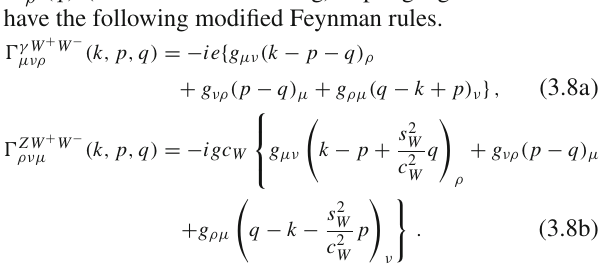
(Fig. 2) using similar arguments. The additional diagrams in Set C (cid:5) (Fig. 6) feature h ( H ) V V interactions and